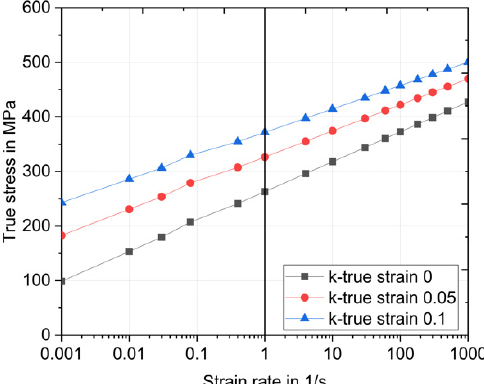
Figure 12. Logarithmic dependence of strain rate and yield strength for three different degrees of true strain.